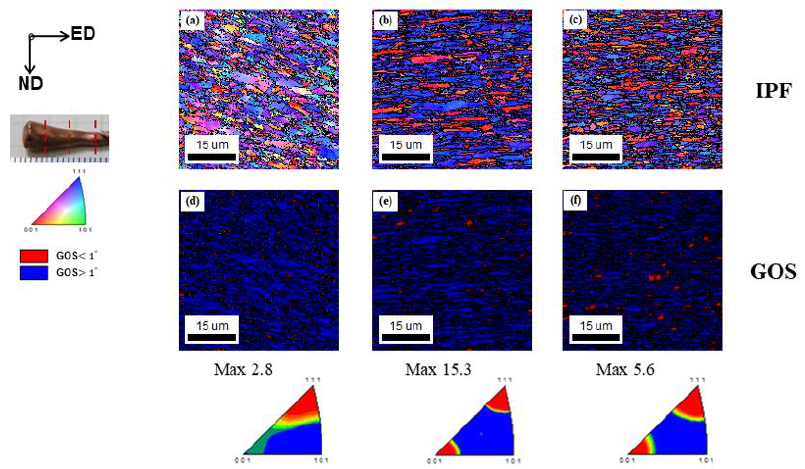
Figure 6. Inverse pole figure (extrusion direction) and GOS maps of FGM Cu at the region of DTE strain level of ( a , d ) 0.5, ( b , e ) 1.0, and ( c , f ) 1.5 in the conical remnant, indicated by red dash lines. The horizontal direction is the DTE direction of the specimen.